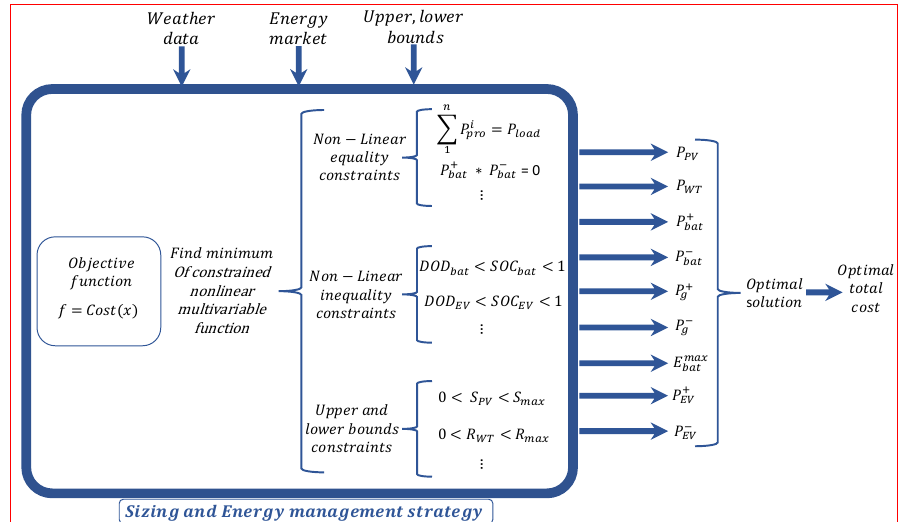
Figure 4. Scheme of the optimization